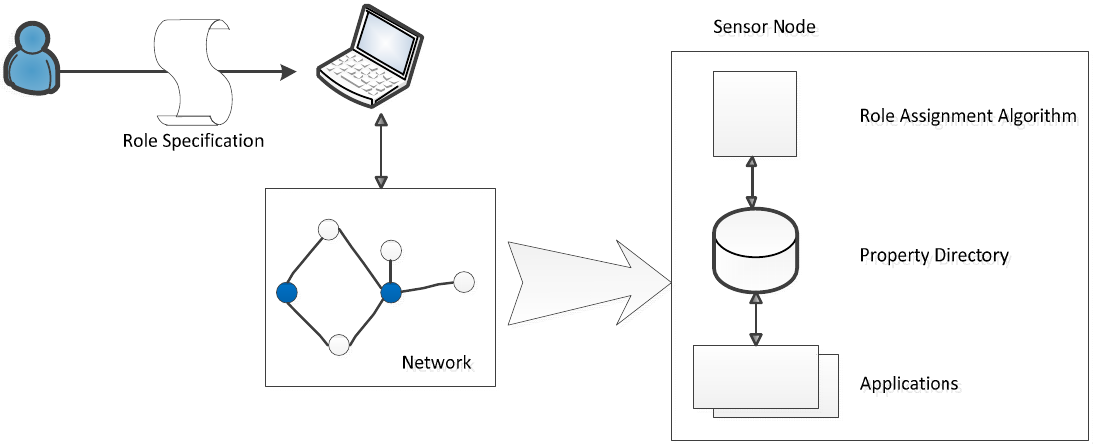
Figure 11. Core elements of the generic role assignment.